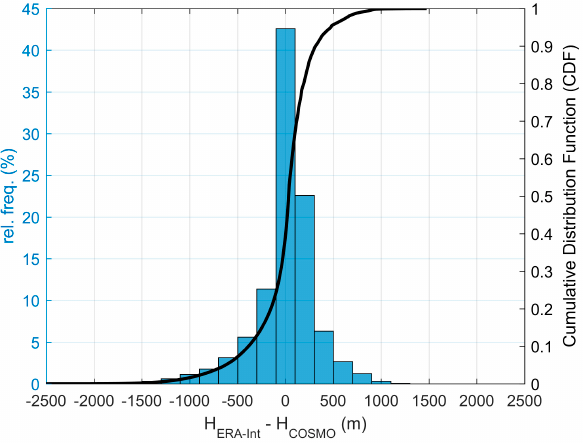
Figure 2. Histogram of orographic differences between ERA-Int and COSMO for the studied area.